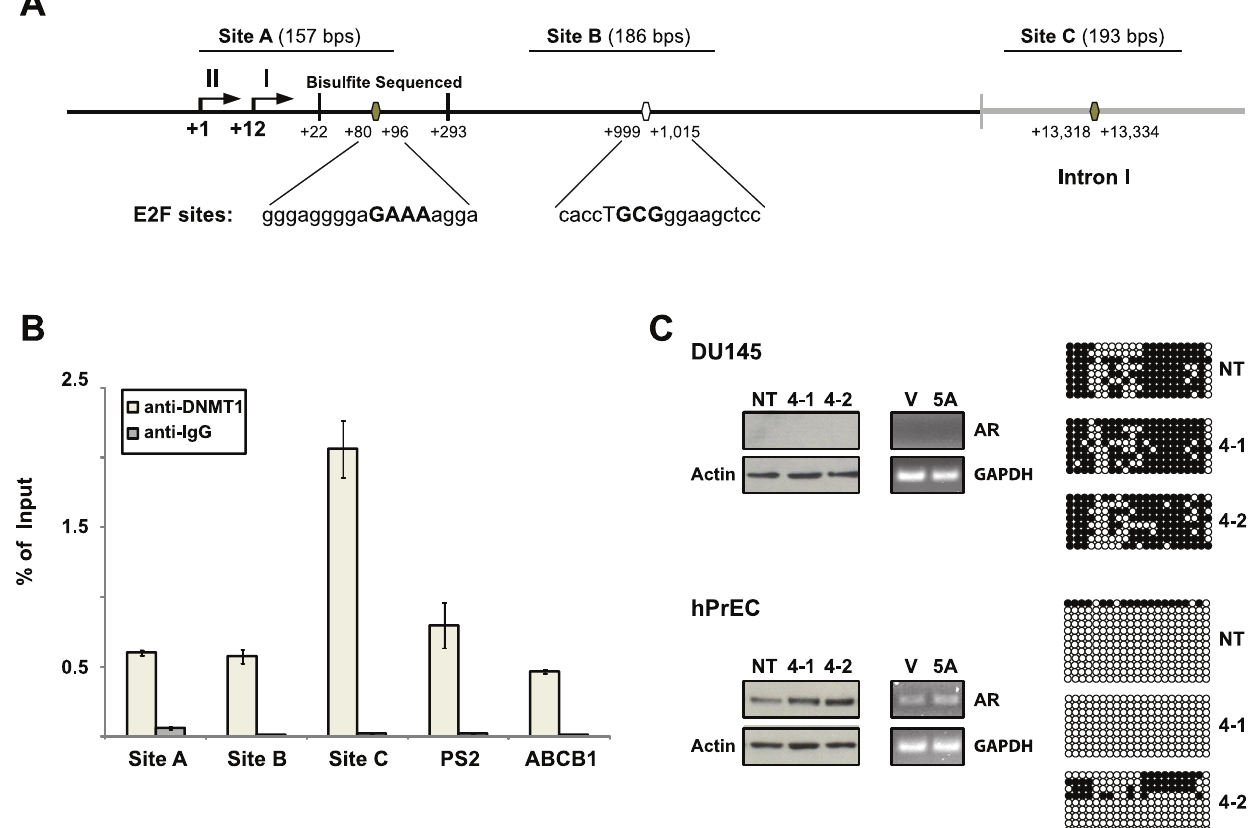
Figure 5. Methylation independent association of DNMT1 with the AR gene. (A) Map of a region of the AR promoter depicting two types of E2F consensus sequences + 80 R + 96 and + 13,318 R + 13,334 (shown as solid ovals) and + 999 R + 1,015 (shown as open ovals). Primer flanked regions are designated as sites A, B, and C. The 243 bp region ( + 22 R + 293) analyzed by bisulfite sequencing is indicated. (B) qPCR analysis of target (DNMT1) and non-specific (IgG) ChIPed DNA from BPH-1 cells using primers that flank sites A, B, and C. Primers flanking a region in the PS2 (targeted DNMT1) promoter and ABCB1 (non-targeted DNMT1) region were used as ChIP controls. Data is representative of the mean from 3 qPCR reactions and shown as a percent of input with the standard error indicated. (C) Bisulfite sequencing analysis of the 243 bp region in the AR minimal promoter in hPrEC compared to DU145 cells infected with both non-targeting (NT) (control) and DNMT1 shRNA constructs (4-1 and 4-2). Solid circles (methylated) and open circles (un-methylated) were used to represent the methylation status of cytosines within CpG dinucleotides. Each horizontal strand of circles depicts a separate DNA clone. Lysates were probed on a western blot for AR and actin. Cell lines were also treated with either 1 m M 5Aza (5A) or DMSO matched vehicle (V) and extracted cDNA was PCR amplified with both human AR and GAPDH. All data shown except for the 5Aza treatments are representative of 3 separate experimental replicates.